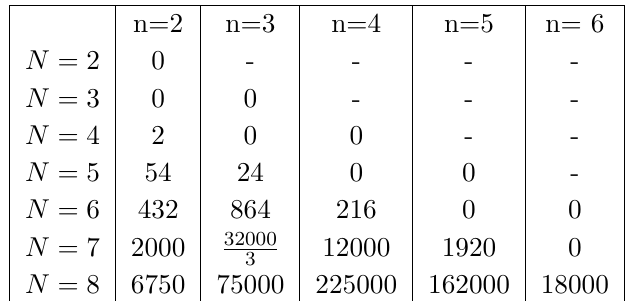
Table 2 . Evaluation of hO